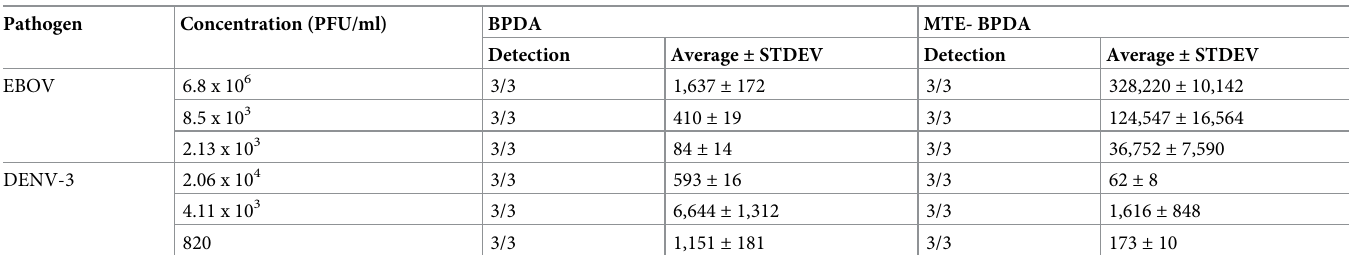
Table 3. Mock clinical detection.